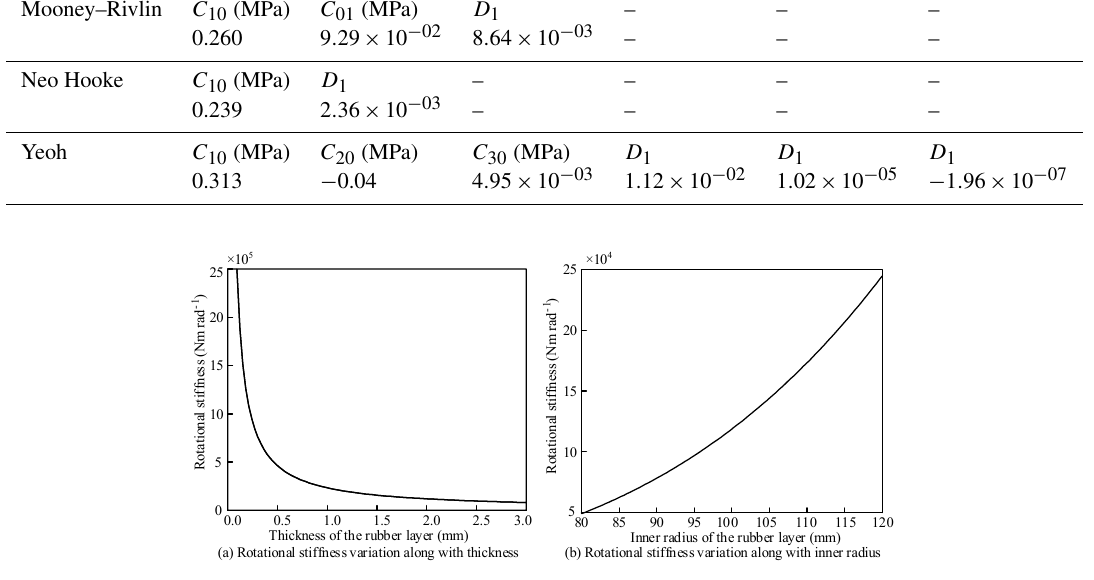
Figure 6. Rotational stiffness variation along with thickness and inner radius.